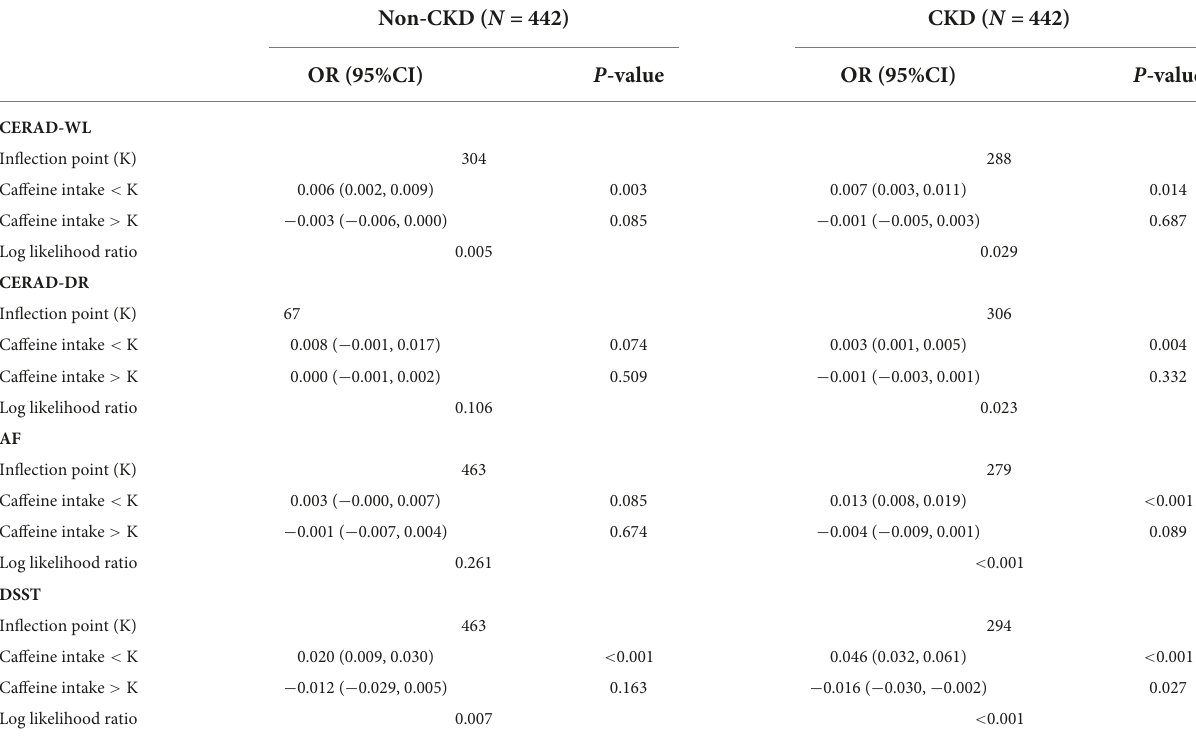
TABLE 3 Threshold effect analysis of each cognitive test and caffeine intake in Non-CKD and CKD subjects using the two-piecewise linear regression